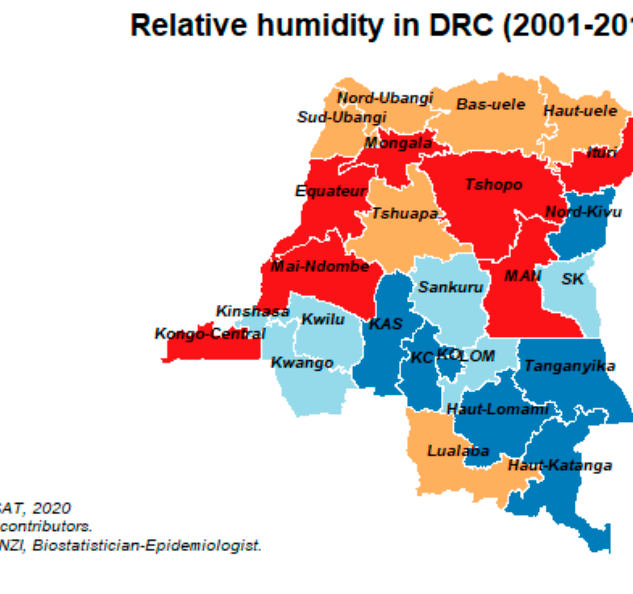
Figure A2. Map of relative humidity (%) in DRC 2001–2019.